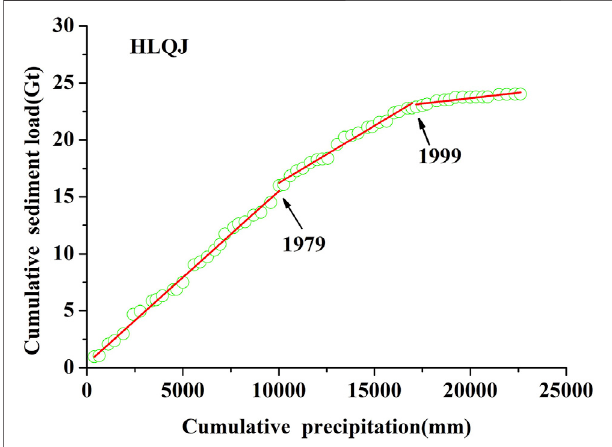
FIGURE4 | Double masscurve of precipitation and sedimentload in the Hekou-Longmen region.